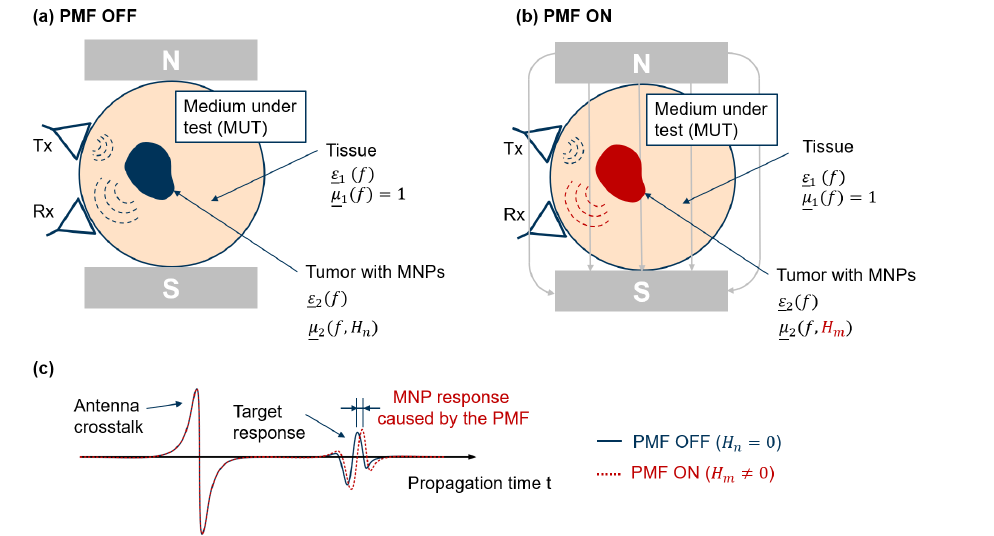
Figure 1. Illustration of the contrast-enhanced MWI scenario for an ON/OFF modulation of the external PMF ( a ) without the presence of a PMF and ( b ) with the presence of a PMF; ( c ) resulting IRFs for both PMF